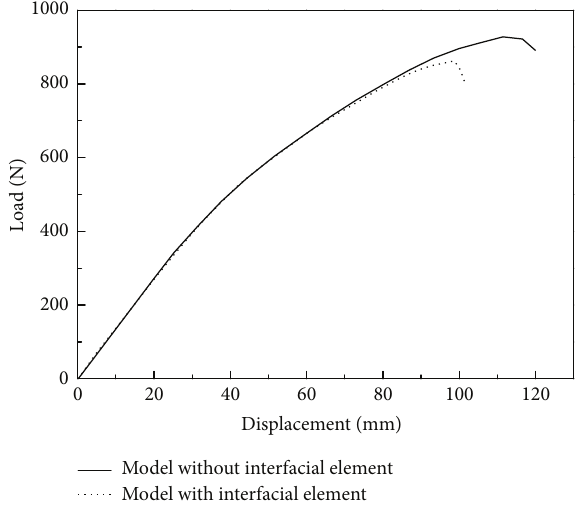
Figure 5: Load-displacement curve of